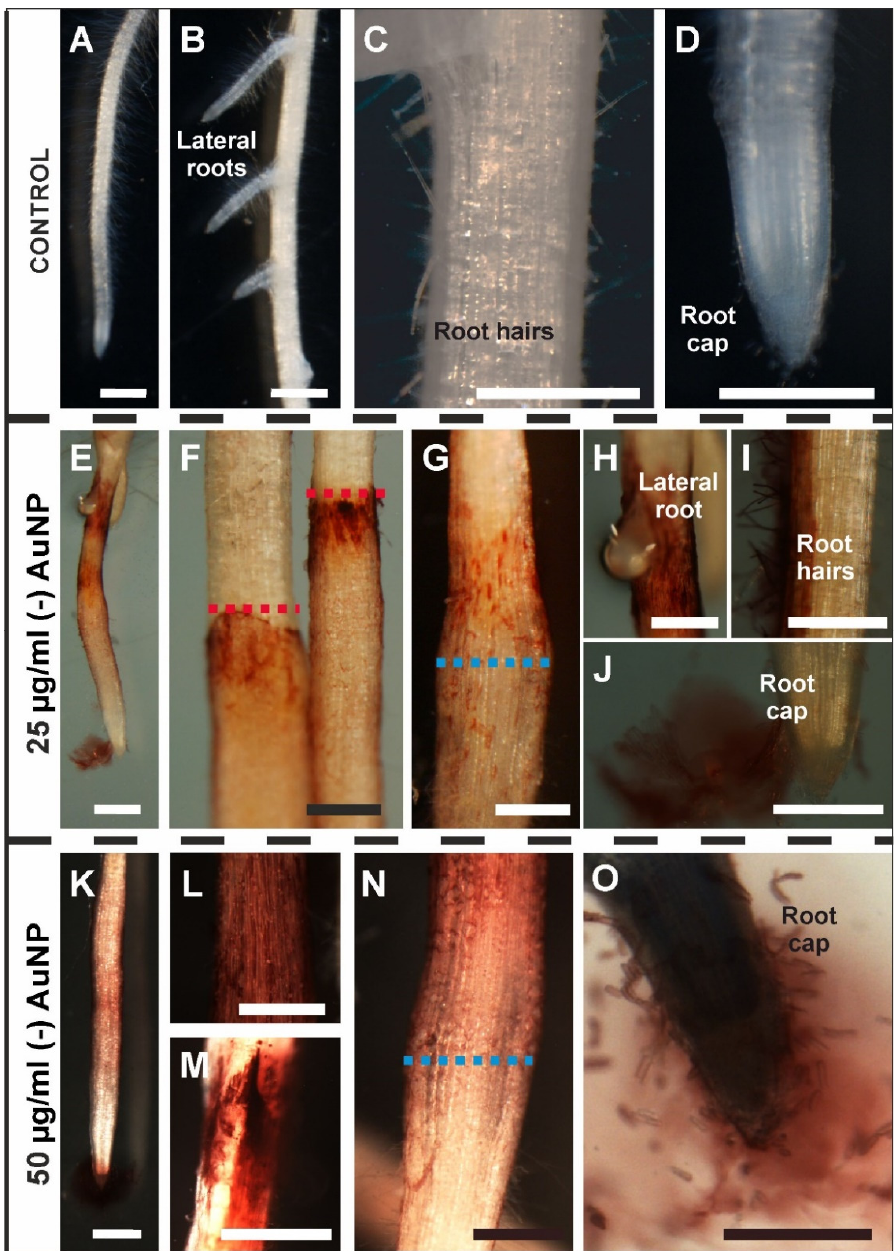
Figure 1. Morphology of the barley roots that were growing in the control conditions ( A – D ), 25 μ g/mL ( ‐ ) AuNP ( E – J ) or 50 μ g/mL ( ‐ ) AuNP ( K – O ). The red dotted lines indicate the boundary level of the ( ‐ ) AuNP solution in which the roots were growing; blue dotted lines indicate the local radial thickening of the roots. Scale bars: ( A , E , K ) = 1 mm; ( B – D , F – J , L – O ) = 0.5 mm.